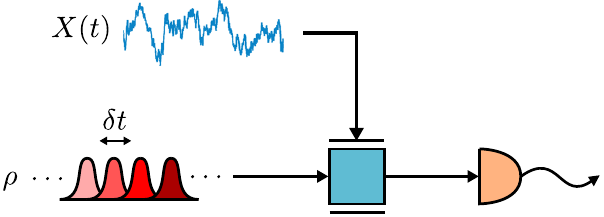
FIG. 4. The continuous waveform estimation problem. The signal X ð t Þ varies continuously, and the system may be approxi- mated by regarding the state as consisting of (typically entangled) modes of length δ t , over each of which X ð t Þ does not vary